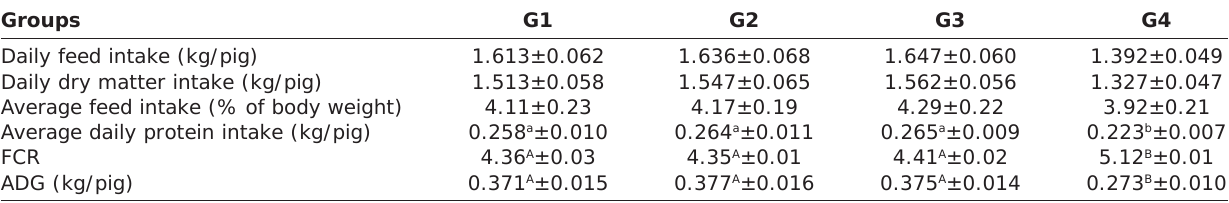
Table-5: Effect of bread waste feeding on feed intake, feed conversion efficiency, ADG of growing crossbred pigs.